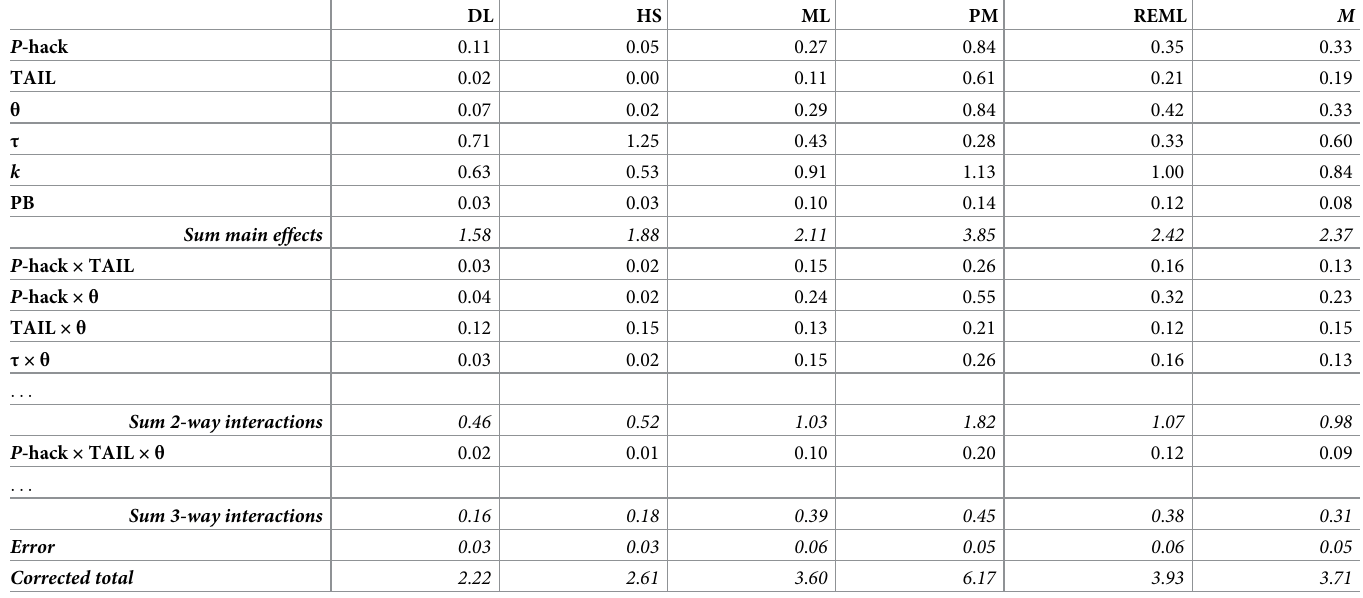
Table 3. The relative importance of design factors for T rmse . Selected sum of squares from six-factorial ANOVA for five heterogeneity estimators.